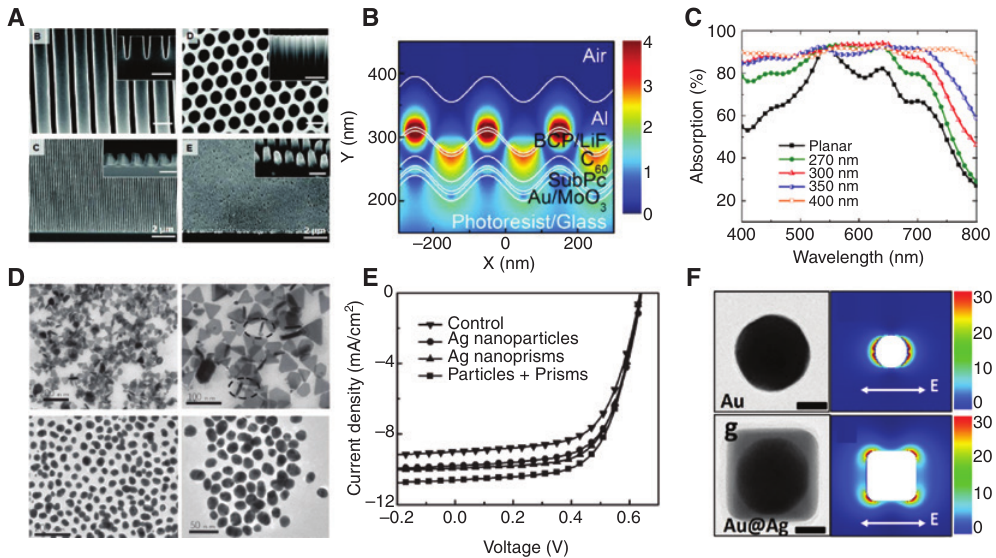
Figure 8: Nanostructures enhances light trapping based on plasmonic effect. (A) SEM images of 1-D and 2-D periodic gratings (reprint with permission Ref. [109]; Copyright 2009 American Chemical Society). (B) Simulated distribution of the magnetic field intensity in the corrugated OPVs at the wavelength of 450 nm based on 200-nm periodic Al cathode, and the device structure can also be obtained in the figure (reprint with permission Ref. [44]; Copyright 2015 Elsevier B.V.). (C) Simulated absorption spectra of OPVs based on CuPc/C heterojunction with 270-, 300-, 350- and 400-nm periodic Ag grating (reprint with permission Ref. [10]; 60 Copyright 2012 American Institute of Physics). (D and E) Transmission electron microscopy (TEM) images of spherical Ag NPs and triangular Ag nanoprisms, and J - V characteristics of OPVs with and without metal NPs (reprint with permission Ref. [92]; Copyright 2013 Wiley-VCH Verlag GmbH & Co. KGaA, Weinheim). (F) TEM images of AuNPs and Au@Ag NCs (scale bar: 20 nm), and simulated electric field | E | 2 distributions of AuNPs (45 nm) and Au@Ag NCs (45 nm @ 10 nm) (reprint with permission Ref. [110]; Copyright 2014 American Chemical